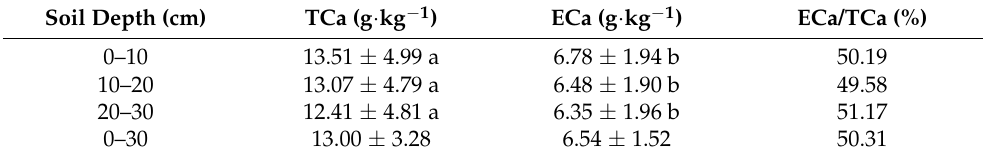
Table 2. Statistics of soil calcium content.